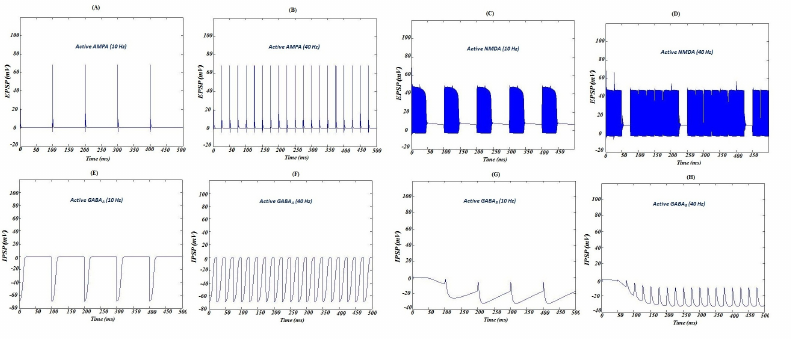
Figure 4. Top Panel: Postsynaptic activity due to excitation. (A and B) Activity due to the AMPA mediated current and (C and D) Activity due to NMDA mediated current. Bottom Panel: Postsynaptic activity due to inhibition. E and F Activity due to the ionotropic GABA A channel and G and H Activity due to the active metabotropic GABA B channels. Clearly the response of GABA B currents is different than to GABA A current as the later one requires a strong stimuli to activate due to its metabotropic